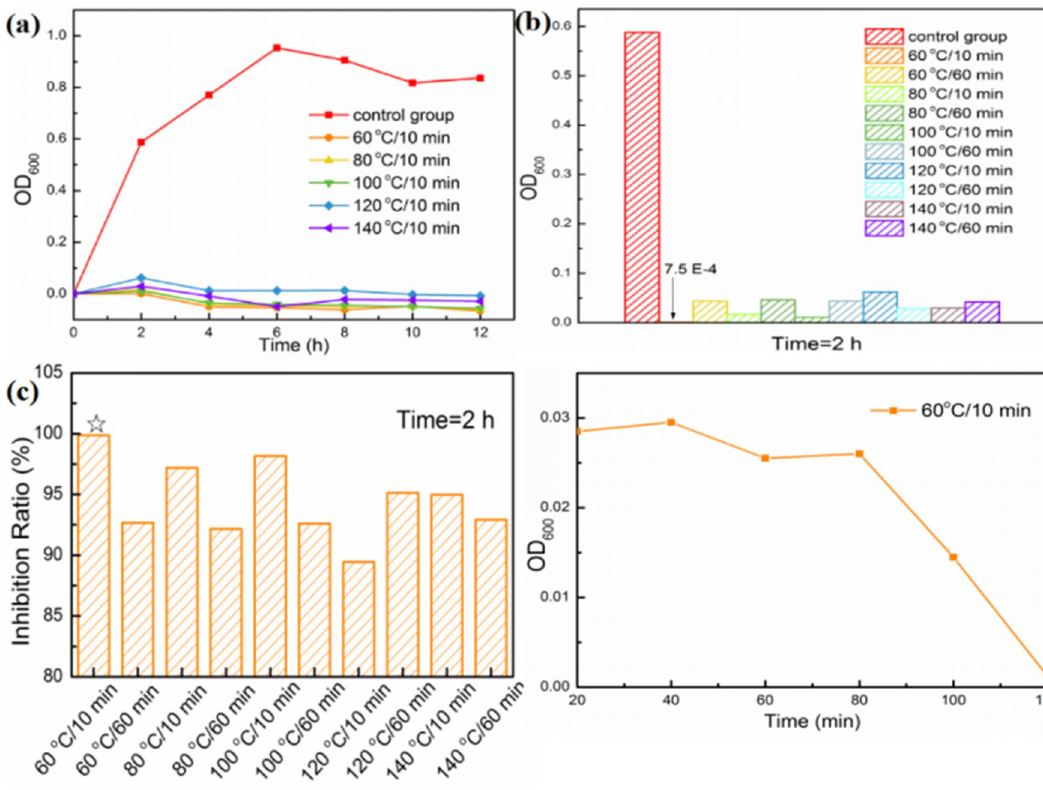
2 O NPs under different preparation conditions after 2 h. ( c ) Inhibition ratios of E. coli co-cultured with Ag 2 O NPs under different preparation conditions after 2 h. ( d ) Growth curve of E. coli co-cultured with Ag 2 O NPs (60 °C/10 min) within 2 h.